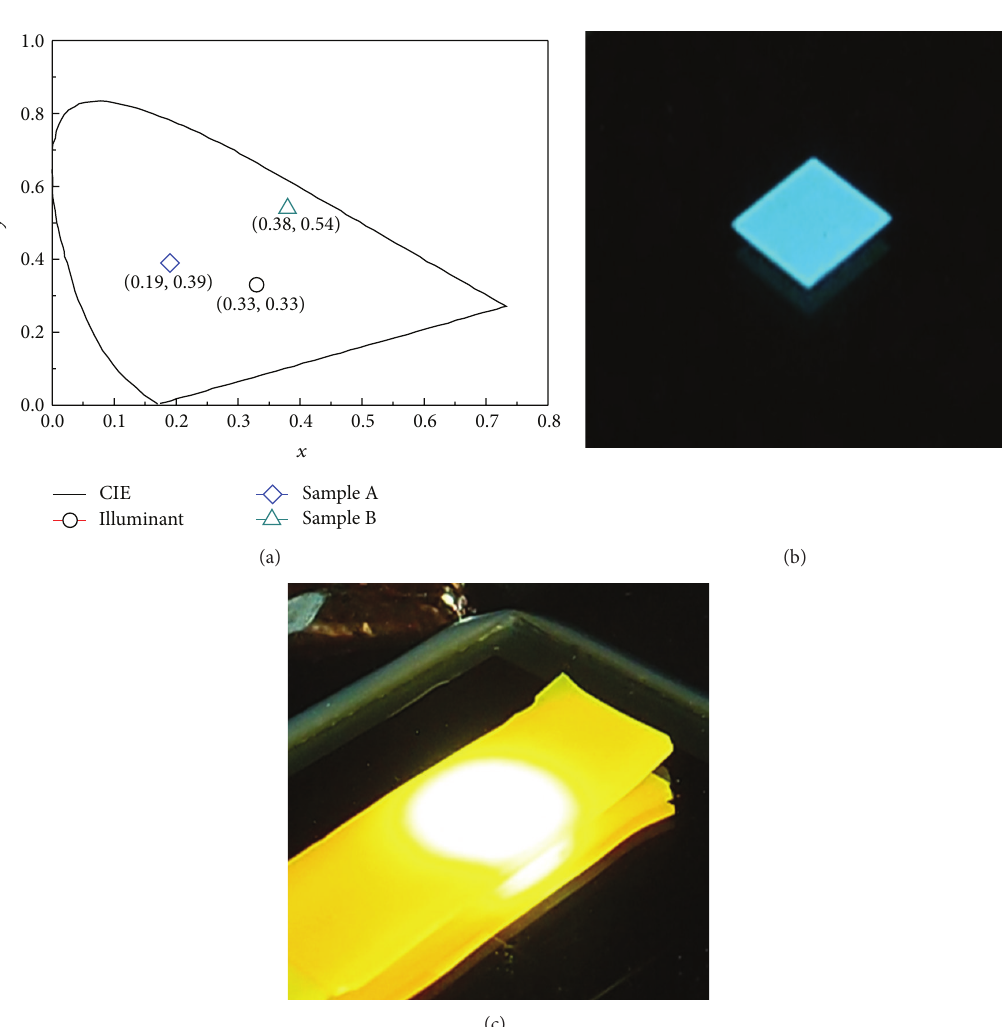
Figure 5: (a) The CIE coordinates of Sample A and Sample B. (b) The blue light photography of Sample A. (c) Warm white light photography of Sample